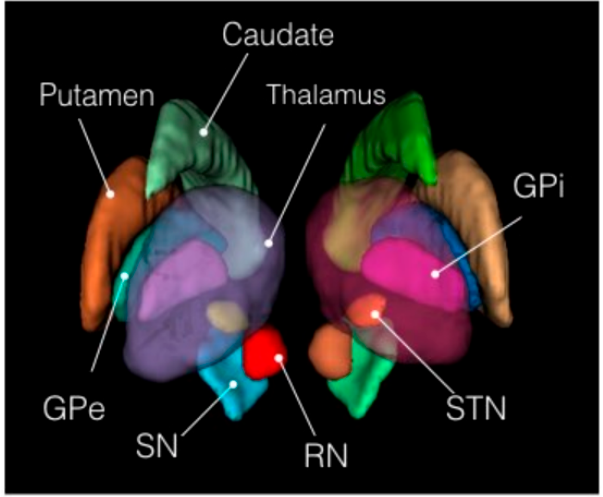
Figure 4. 3D view of the eight subcortical structures. Source: http://nist.mni.mcgill.ca/?p=1209.